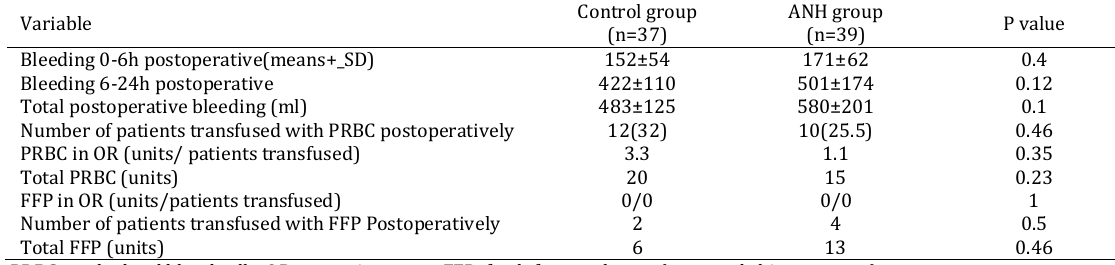
Table 4. Postoperative hematological data in the study groups Variable Hemoglobin